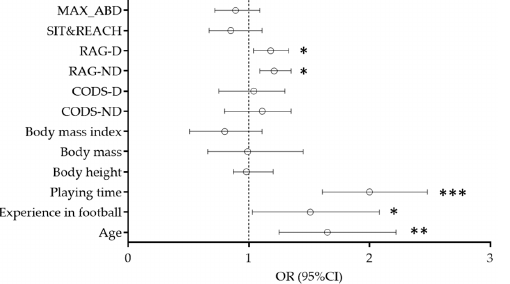
Figure 3. Results of the univariate logistic analysis for prediction of injury occurrence (*** p < 0.001, ** p < 0.01, * p < 0.05) When all significant predictors were simultaneously included in multivariate logistic regression, significant associations were retained for playing time (OR = 1.81, 95%CI: 1.55– 2.11, p < 0.001) and RAG-ND (OR = 1.15, 95%CI: 1.02–1.28, p < 0.05), with proper model fit as indicated by Hosmer Lemeshow test ( p > 0.05). Specifically, players who were more involved in the game and who performed poorly in the reactive agility task on the non- dominant side were more prone to injury over the study period (Figure 4). Figure 4. Results of the multivariate logistic analysis in prediction of injury occurrence (*** p < 0.001, * p < 0.05) 4. Discussion The main aim of this study was to investigate the influences of RAG and CODS agil- ity components on injury occurrence in professional football players, and we hypothe- sized lower risks of injury in players who performed better on the football-specific tests of CODS and RAG. Regarding this, there are several important findings of the study. First, at the univariate level, older age, longer playing time, and poor performances in both RAG tests (RAG-ND, and RAG-D) were identified as risk factors for injury occurrence. How- ever, the multivariate model identified longer playing time and poorer RAG-ND as the only significant risk factors for injury occurrence. As a result, our initial hypothesis may be partially accepted. 4.1. Age and Playing Time as Predictors of Injury Our results suggest that older football players are more prone to injuries, and this is generally supported by previous reports. Even studies carried out 30 years ago have